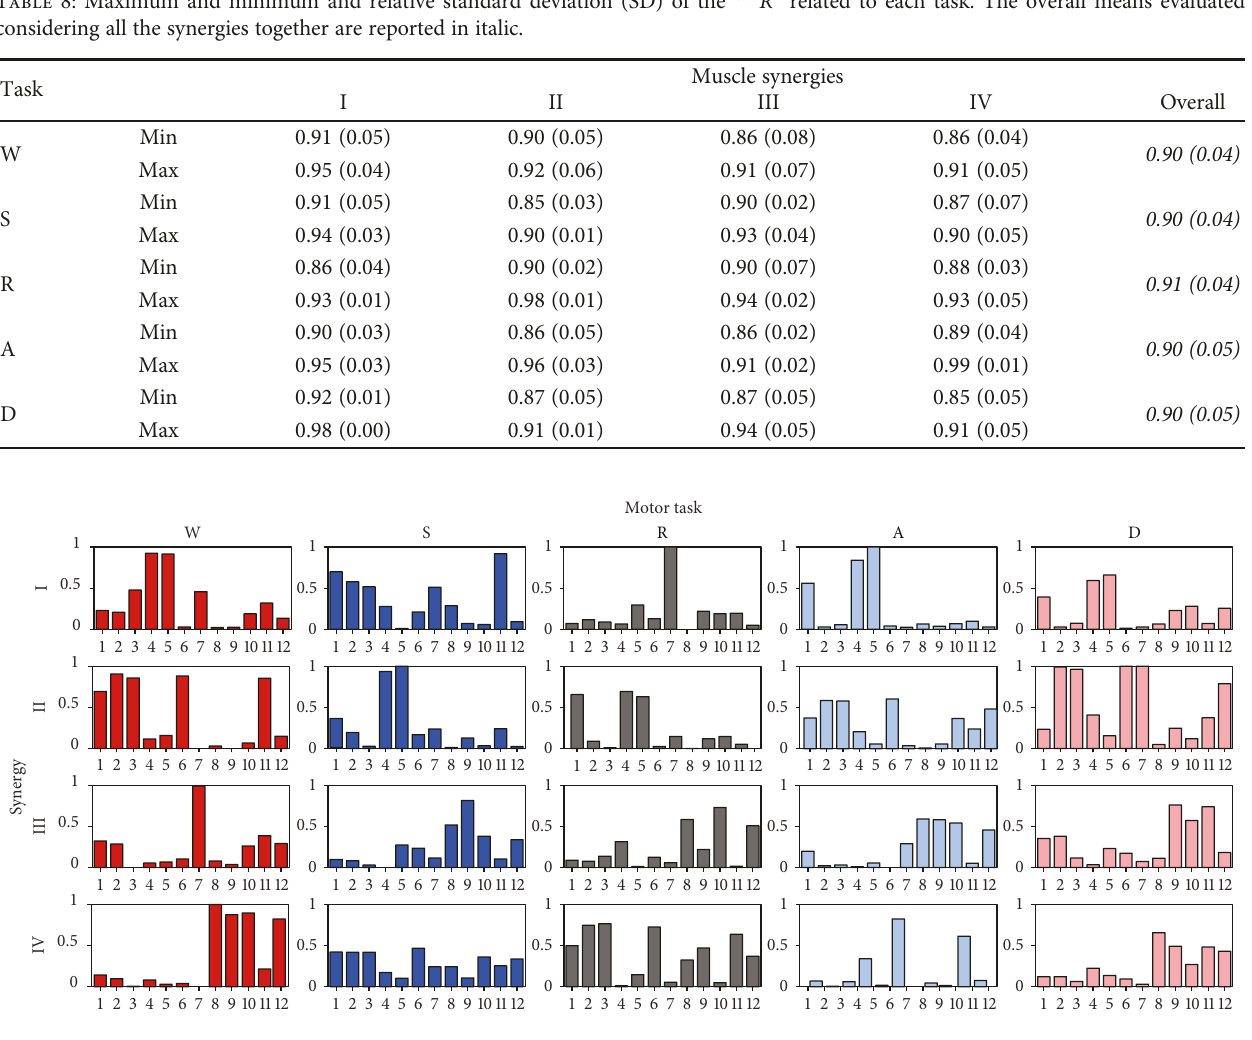
Figure 6: Mean value of muscle synergy vectors in the 4-synergy model related to each daily life activities. The mean has been obtained by averaging across subjects the muscle synergy vector mean of the three sessions of each subject. For visualization purposes, muscle synergy vectors are normalized to unity. Muscle numbers: 1: TFL; 2: REF; 3: VLAT; 4: VMED; 5: PERO; 6: TA; 7: SOL; 8: GLU; 9: SEMT; 10: BIF; 11: LGAS; 12: